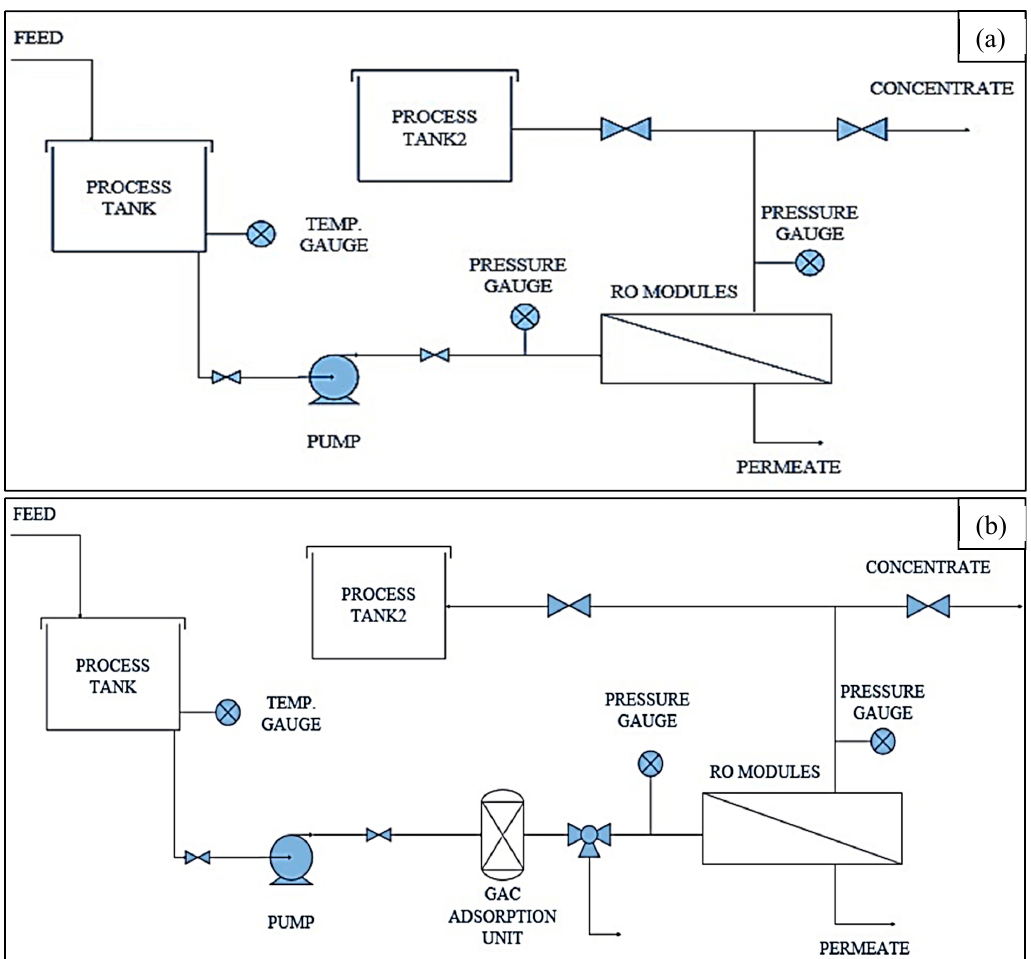
Figure 2. The diagram of an edible oil wastewater treatment unit using ( a ) a polyamide (PA) thin film composite (TFC) reverse osmosis (RO) membrane ( b ) pretreatment unit with a powder carbon filter. Percentage oil rejection and flux